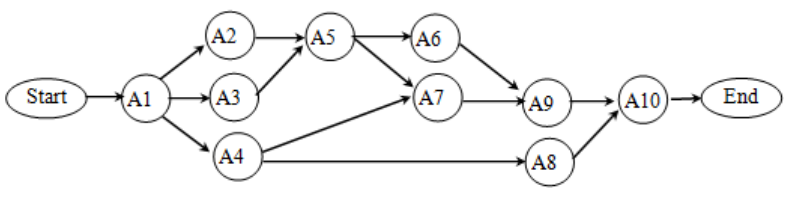
Figure 1. Project network diagram showing activities on node